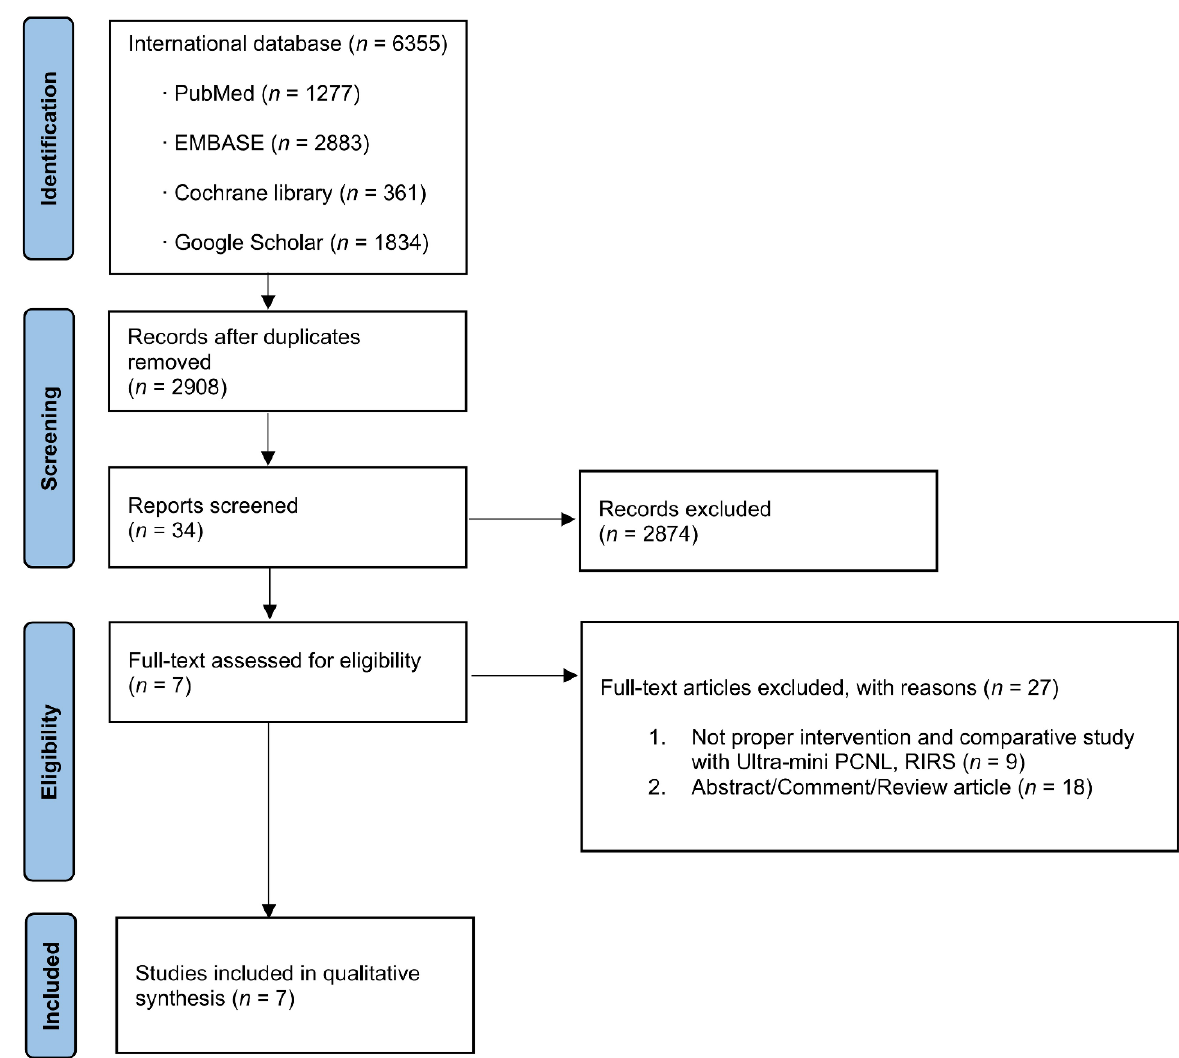
Figure 1. Study flow chart.